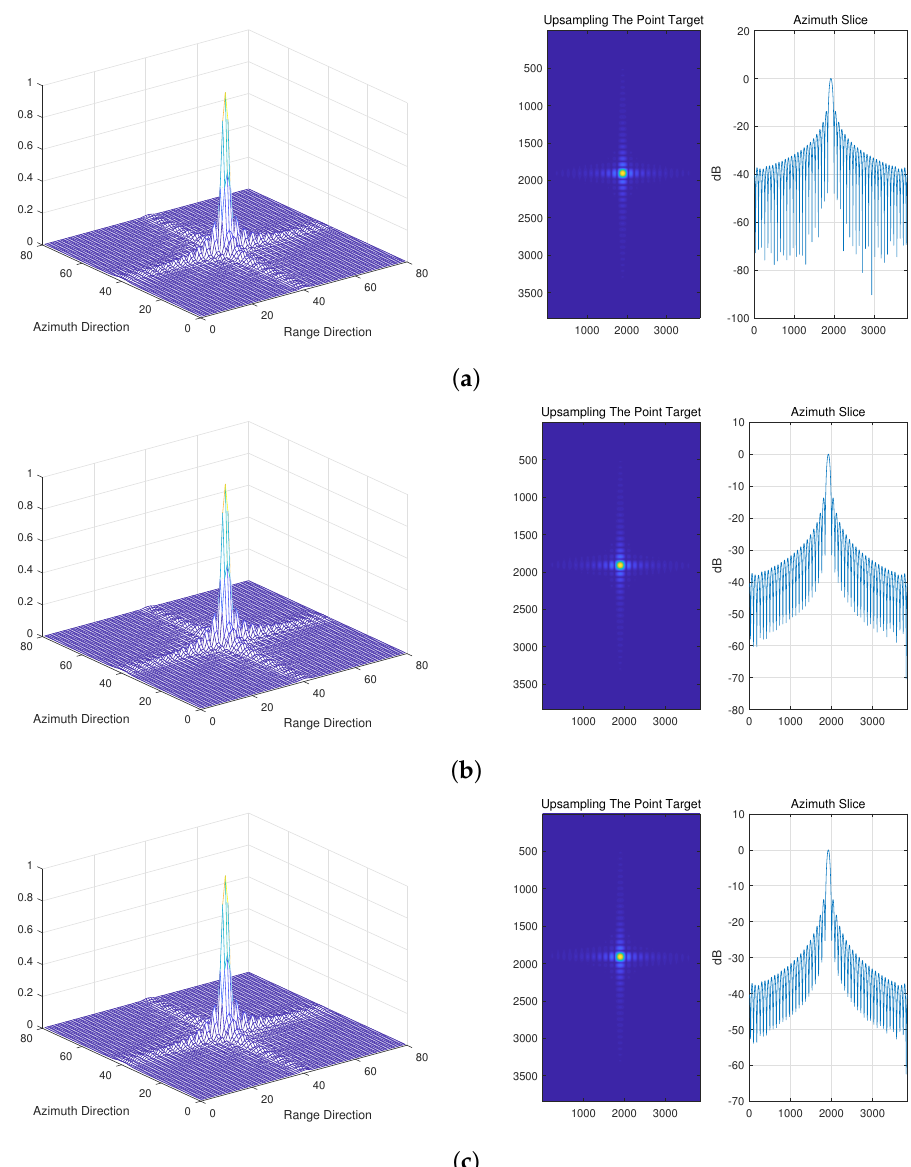
Figure 8. The imaging results of the parabolic antenna with different pointing deviations in the case of alignment. ( a ) Pointing deviation = 0 ◦ ; ( b ) pointing deviation = 1 ◦ ; ( c ) pointing deviation = 2 ◦